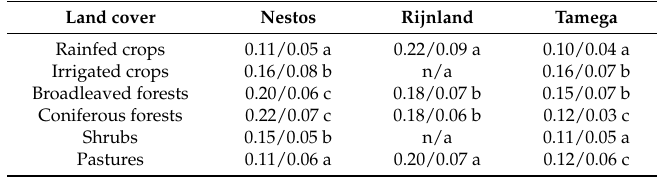
Table 2. SM means and standard deviations per land cover type (cm 3 ¨ cm ´ 3 ).